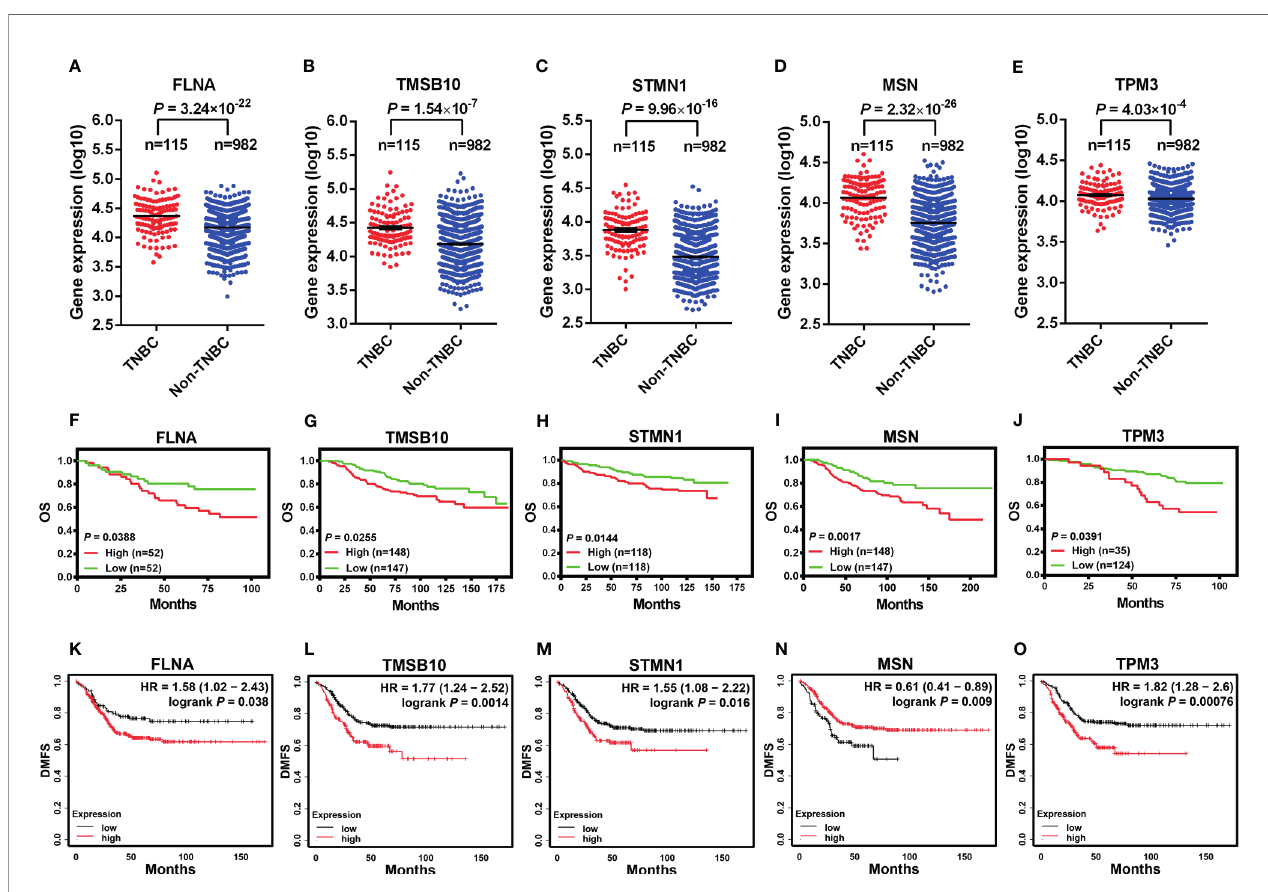
FIGURE 7 | Higher expression levels of cytoskeleton-associated genes are characteristic of TNBC and predict poorer survival outcomes in breast cancer patients. The expression of FLNA (A) , TMSB10 (B) , STMN1 (C) , MSN (D) , SPTAN1 (E) analyzed between TNBC and non-TNBC clinical samples from The Cancer Genome Atlas (TCGA), which was contained in the online cBioPortal for cancer genomics database (A-E) . OS in breast cancer patients retrieved from the online database (PROGgeneV2) between high and low expression of FLNA [ (F) , dataset GSE42568], TMSB10 [ (G) , dataset NKI], STMN1 [ (H) , dataset GSE3494_U133A], MSN [ (I)